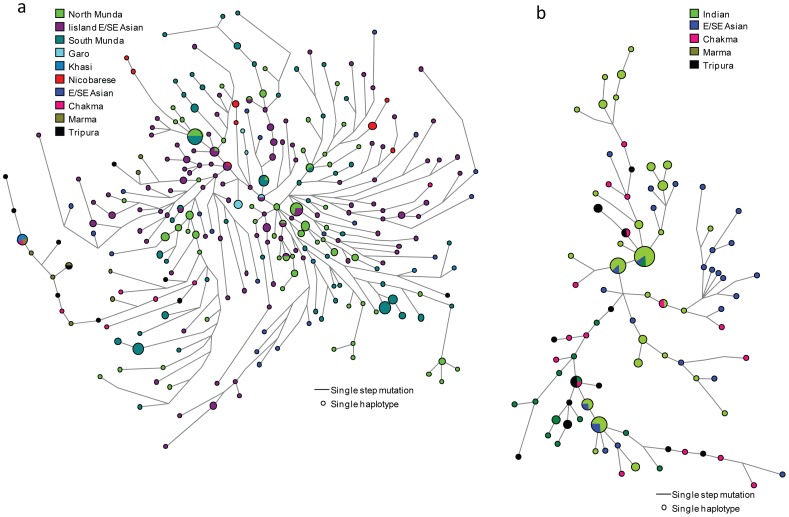
Unrooted phylogenetic network of a) haplogroups M95-O2a1; b) haplogroup M134-O3a2c1.The network was constructed using a median-joining algorithm as implemented in the Network 4.6.0 program. The size of the circles is proportional to the number of samples.